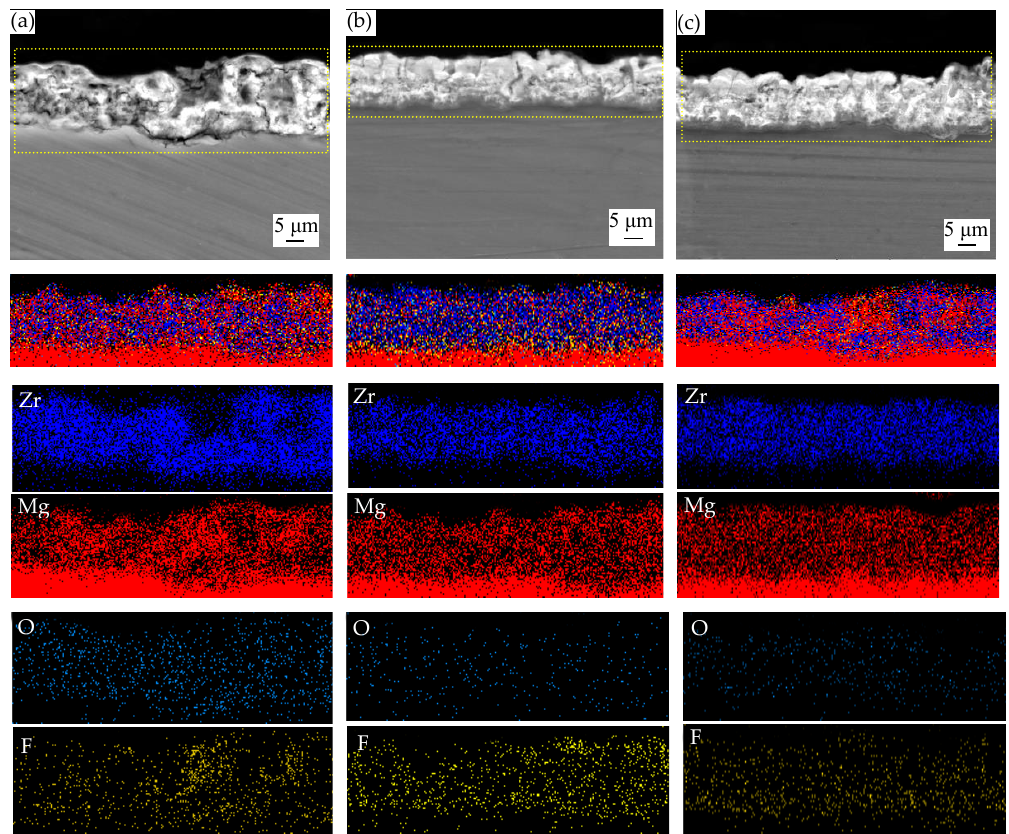
Figure 6. The cross-sectional morphologies and EDS mapping of the coatings: ( a ) NO.3 # ; ( b ) NO.5 # ; ( c ) NO.7 # .